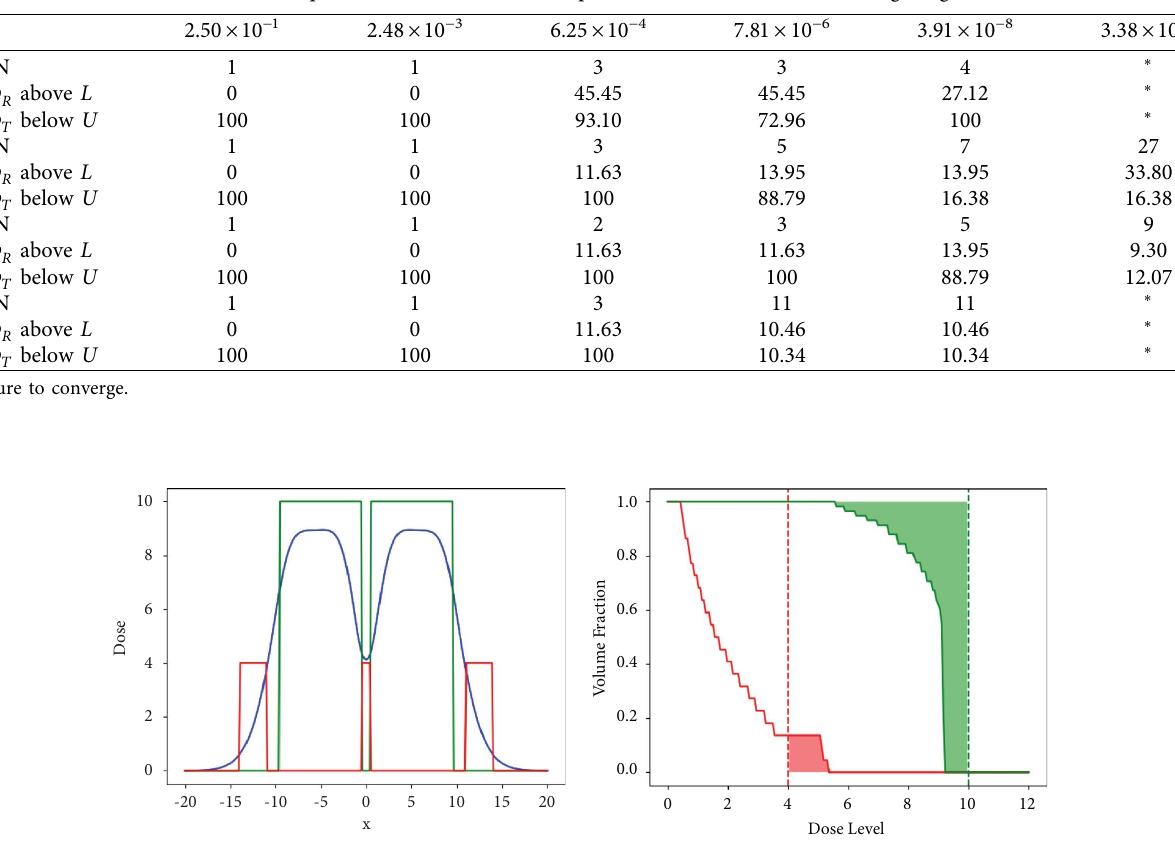
∗ Failure to converge.